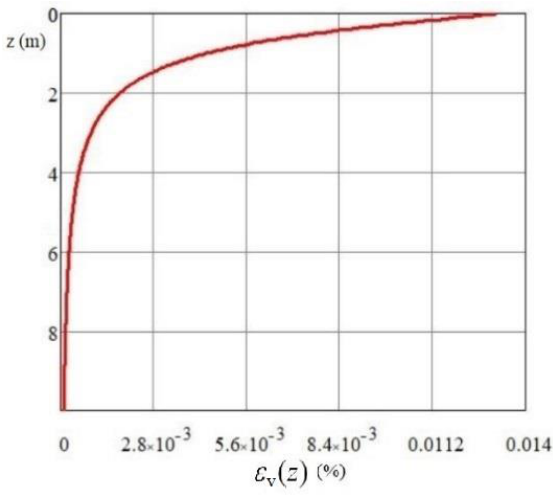
Figure 4. Distribution of ε γ ( z ) with depth z .